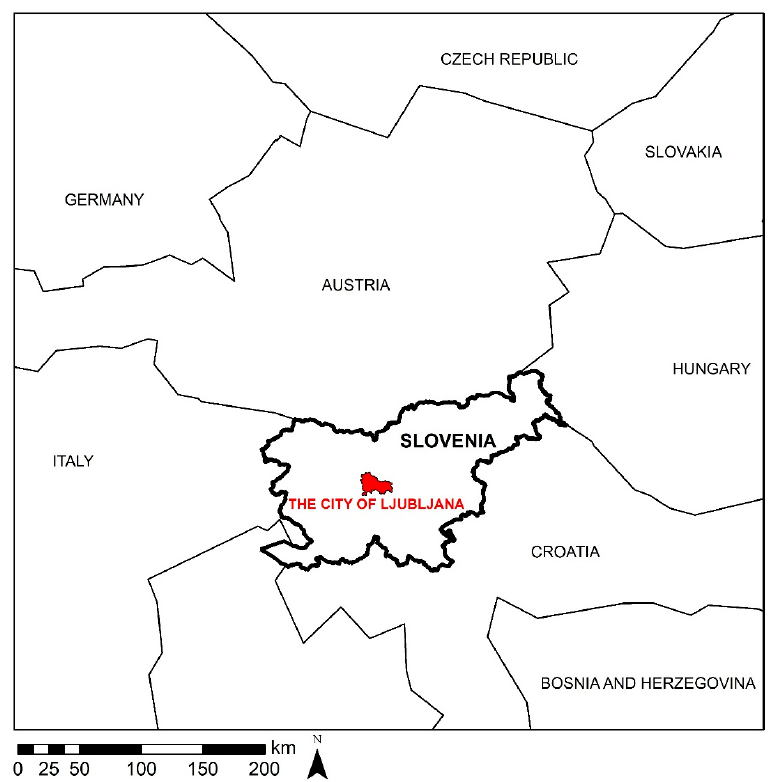
Figure 1. The location of Slovenia with the capital, The city of Ljubljana, in a broader context.